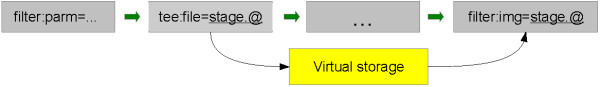
Construction of non-linear pipelines by using theteefilter and virtual storage. Note, the virtual storage is located in main memory.